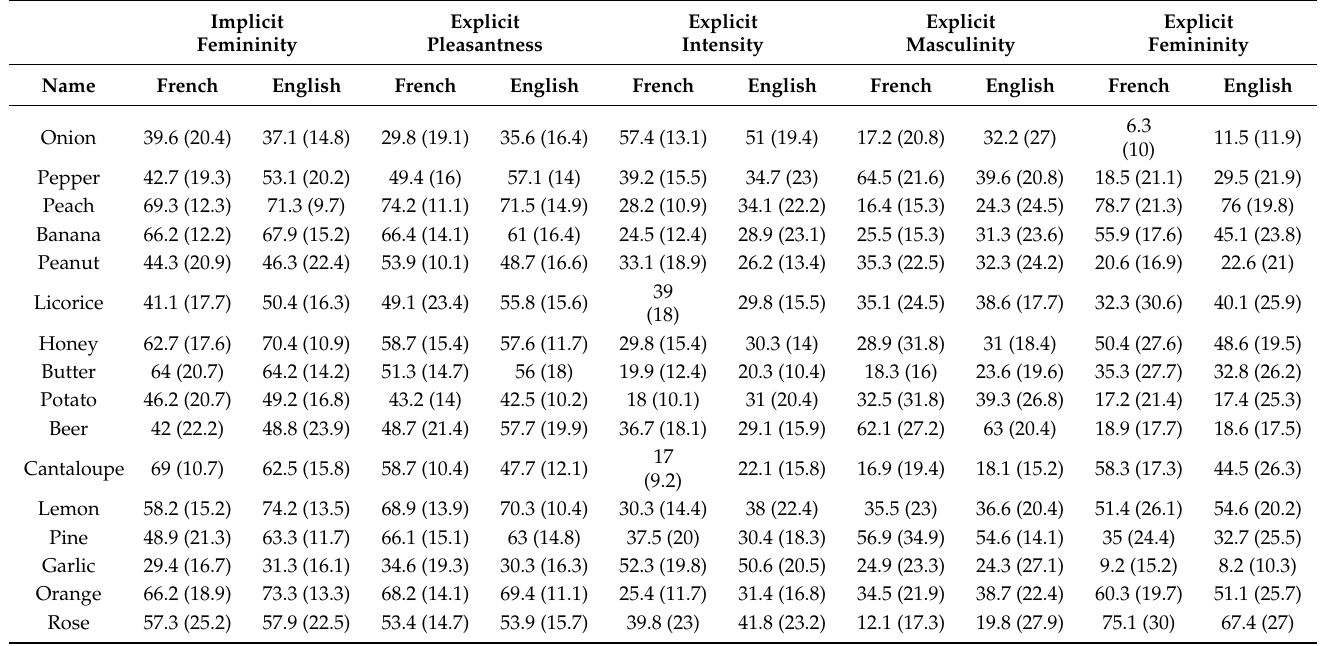
Table 3. Means of explicit and implicit ratings by language group. Standard deviations are indicated in